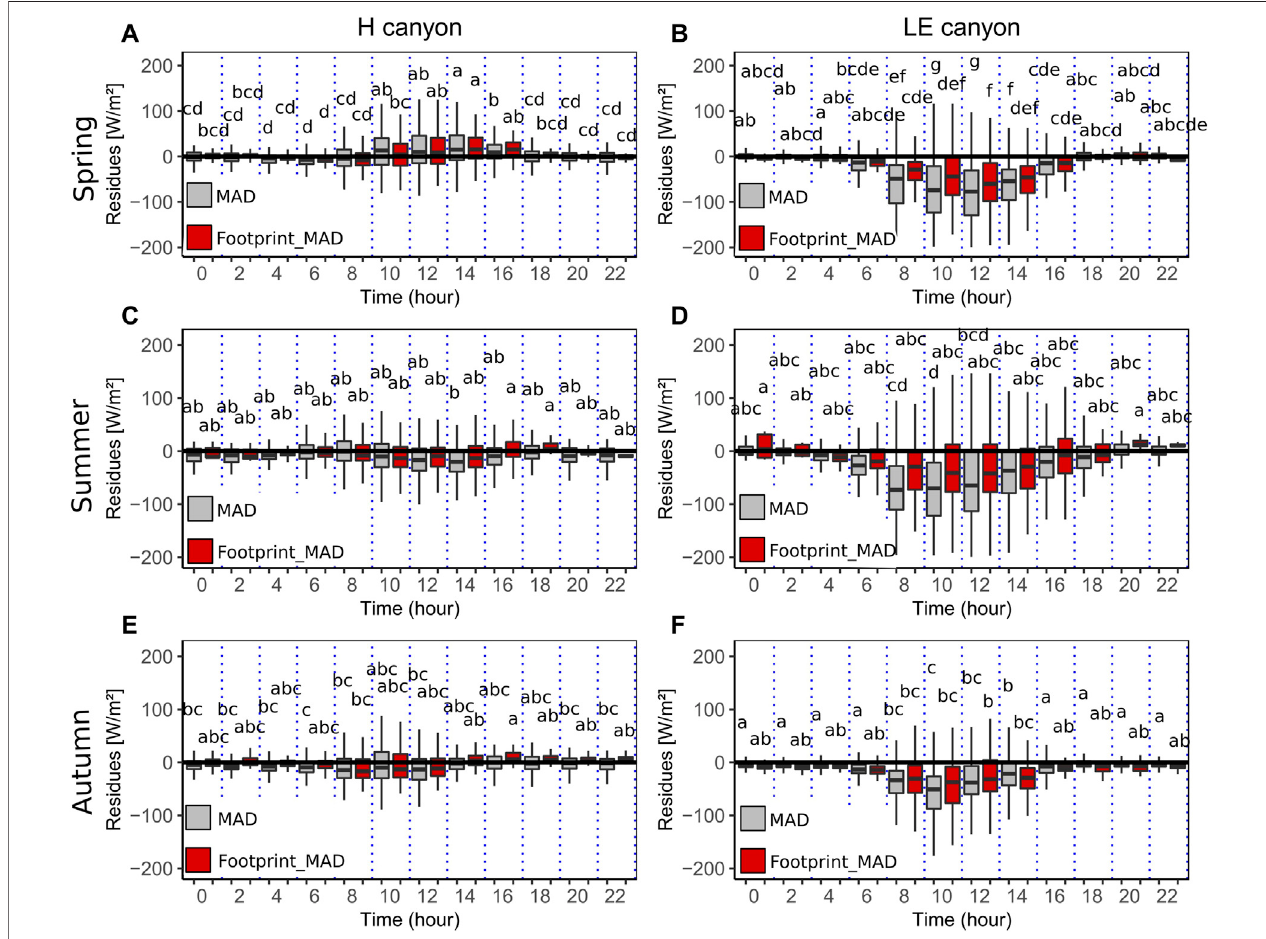
FIGURE 7 | Two-hours boxplots of the residues fi ltered with the MAD (grey) and Footprint_MAD (red) methods for H and LE fl uxes during (A,B) spring, (C,D) summer, and (E,F) autumn, respectively. Are also indicated the results from the pairwise comparison Turkey ’ s HSD statistical test (see text for details and explanations for the